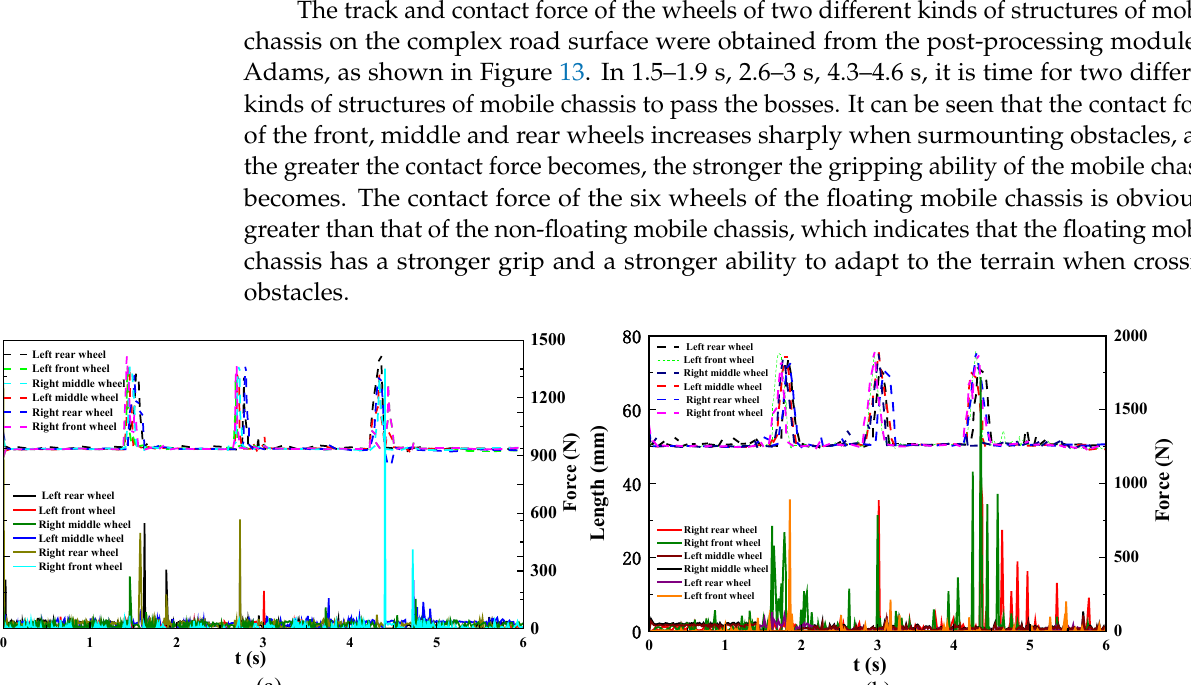
Figure 12. Motion simulation of complex road conditions: ( a ) The obstacle climbing process of float- ing mobile chassis; ( b ) Dynamic simulation of floating mobile chassis under complex road condi- tions.